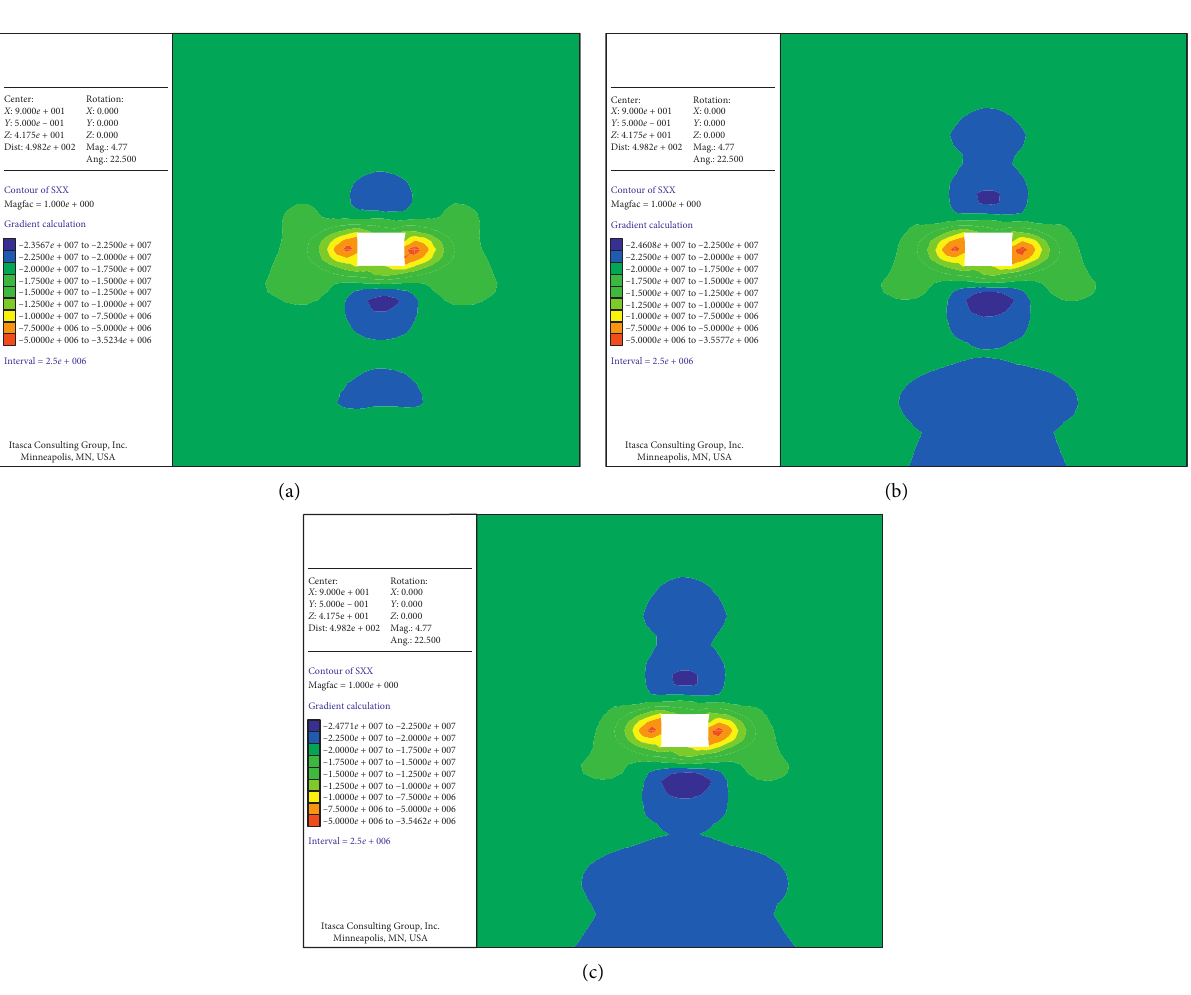
Figure 9: Cloud diagram of horizontal stress. (a) 300 step; (b) 600 step; and (c) 2100